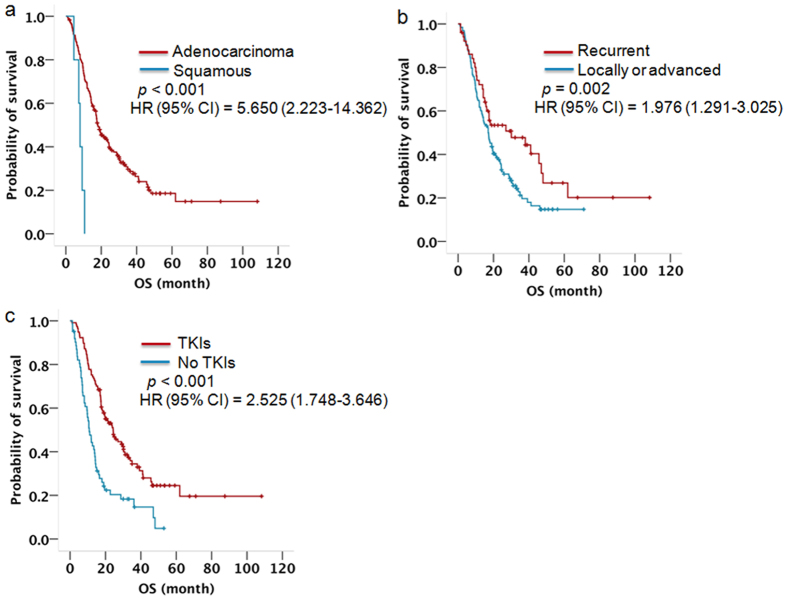
Kaplan-Meier survival curve for patients with activating EGFR mutations stratified by (a) histological type, (b) disease type, (c) EGFR TKI therapy. P-value indicates significance levels from the comparison of survival curves using the Log-rank test.